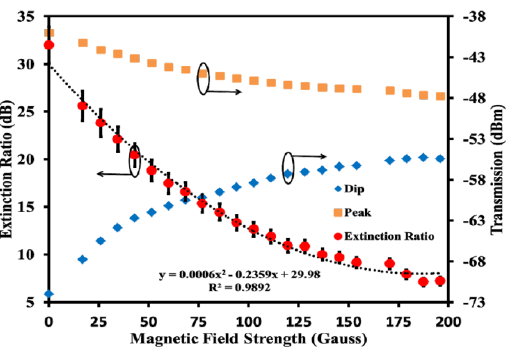
Figure 5. Dependence of the extinction ratio with the magnetic field. Reproduced from [38], with the permission of OSA.